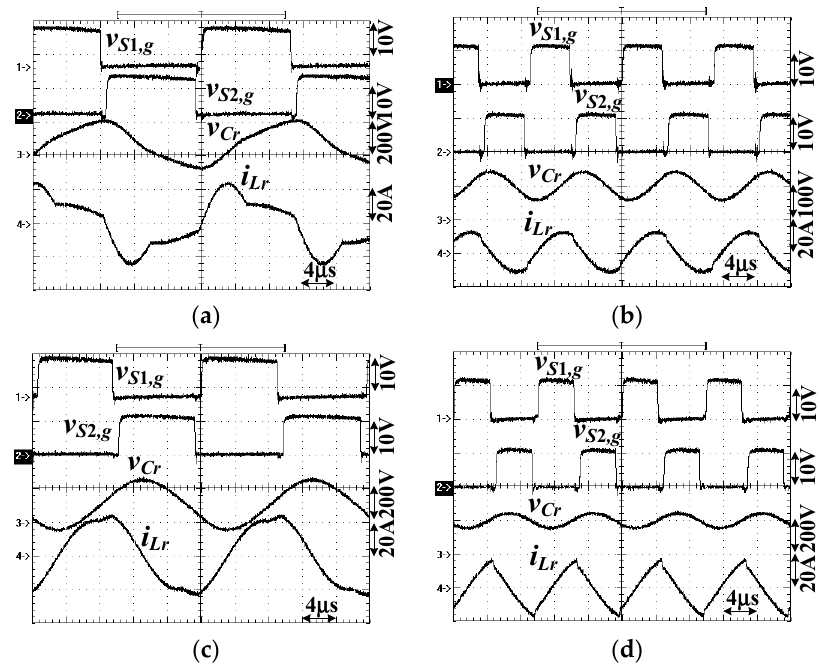
Figure 7. Measured results of v S 1 ,g , v S 2 ,g , v Cr , and i Lr at rated power values of :( a ) V in = 100 V; ( b ) V in = 190 V; ( c ) V in = 210 V; ( d ) V in = 400 V.